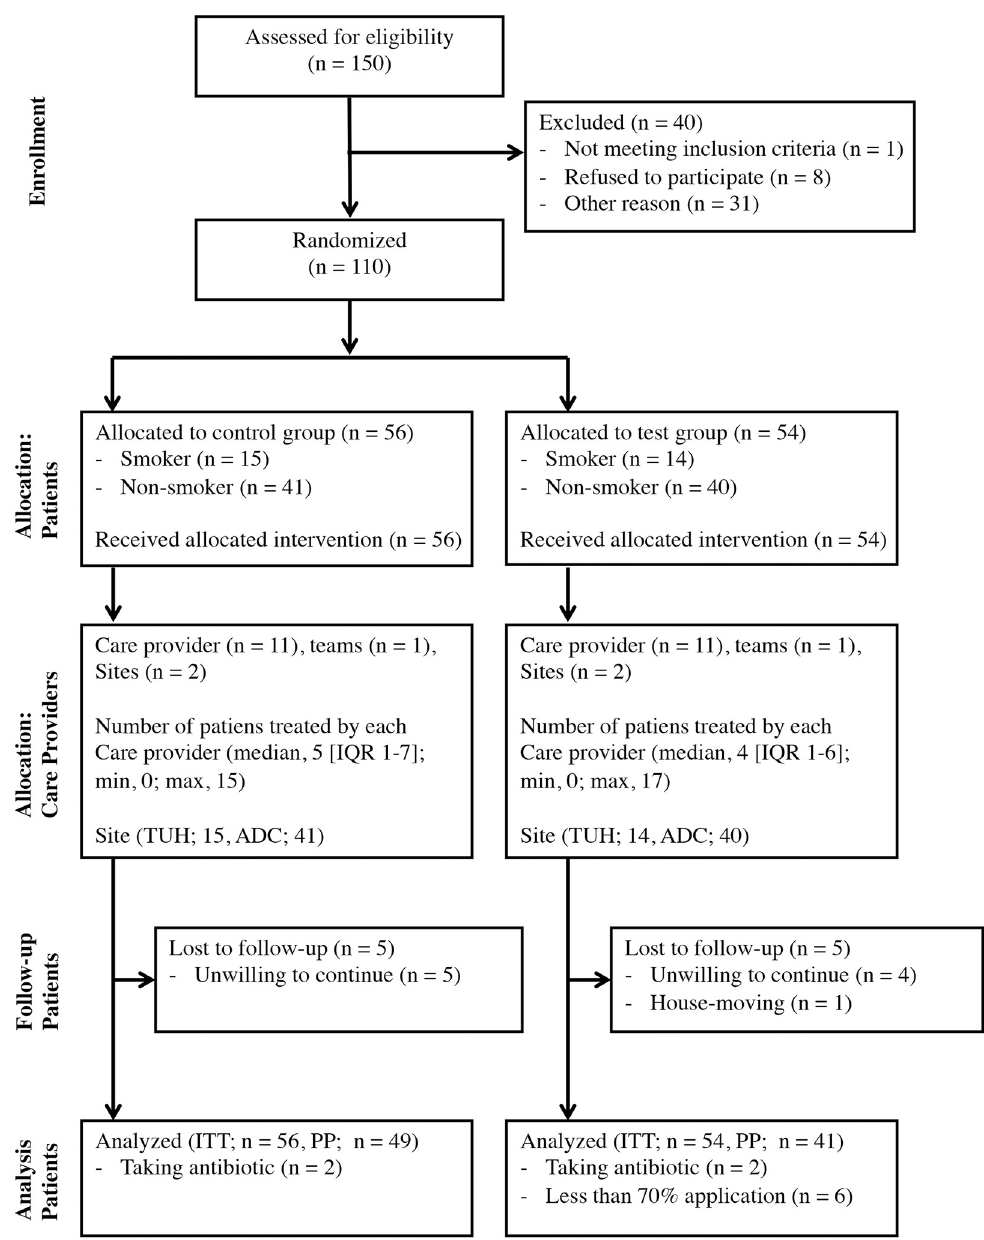
Fig 1. Flow diagram. IQR, interquartile range; TUH, Tsurumi University Dental Hospital; ADC, Ariyoshi Dental Clinic; ITT, intention-to-treat; PP, per-protocol.